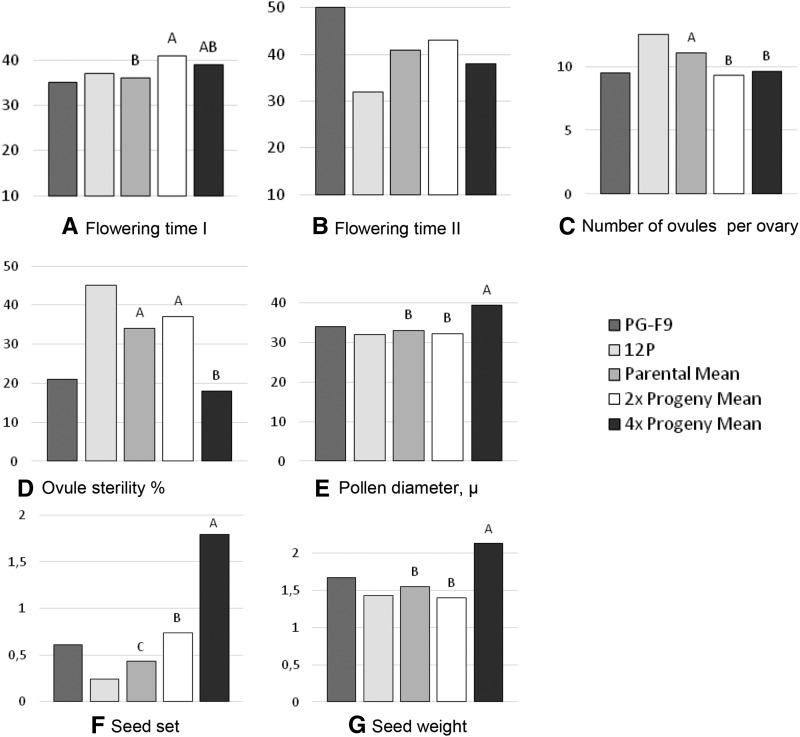
Reproductive traits of parental genotypes, their means, and comparisons with 2x and 4x hybrids (three genotypes per progeny per ploidy level). (A) and (B) Flowering dates of two consecutive regrowths (A, days from June 1; B days from previous cut; n = 2–7 per genotype). (C) Number of ovules per ovary (n = 20–22 per genotype). (D) Percentage of callosized ovules, estimating ovule sterility (n = 20 per genotype). (E) Pollen diameter (n = 30–55 per genotype). (F) Seeds produced per floret upon hand pollinations with an unrelated pollen parent of the same ploidy level (n = 8–30 florets for each of four racemes, used as replications). Genotype by environment and ploidy × environment interactions for seed set were not significant (not shown), so the mean data across environments are presented (Table S12). (G) Weight of 1000 seeds (n = 23–291 per genotype). Different letters above columns indicate significant differences at P < 0.05 (see text for details on statistical analyses).